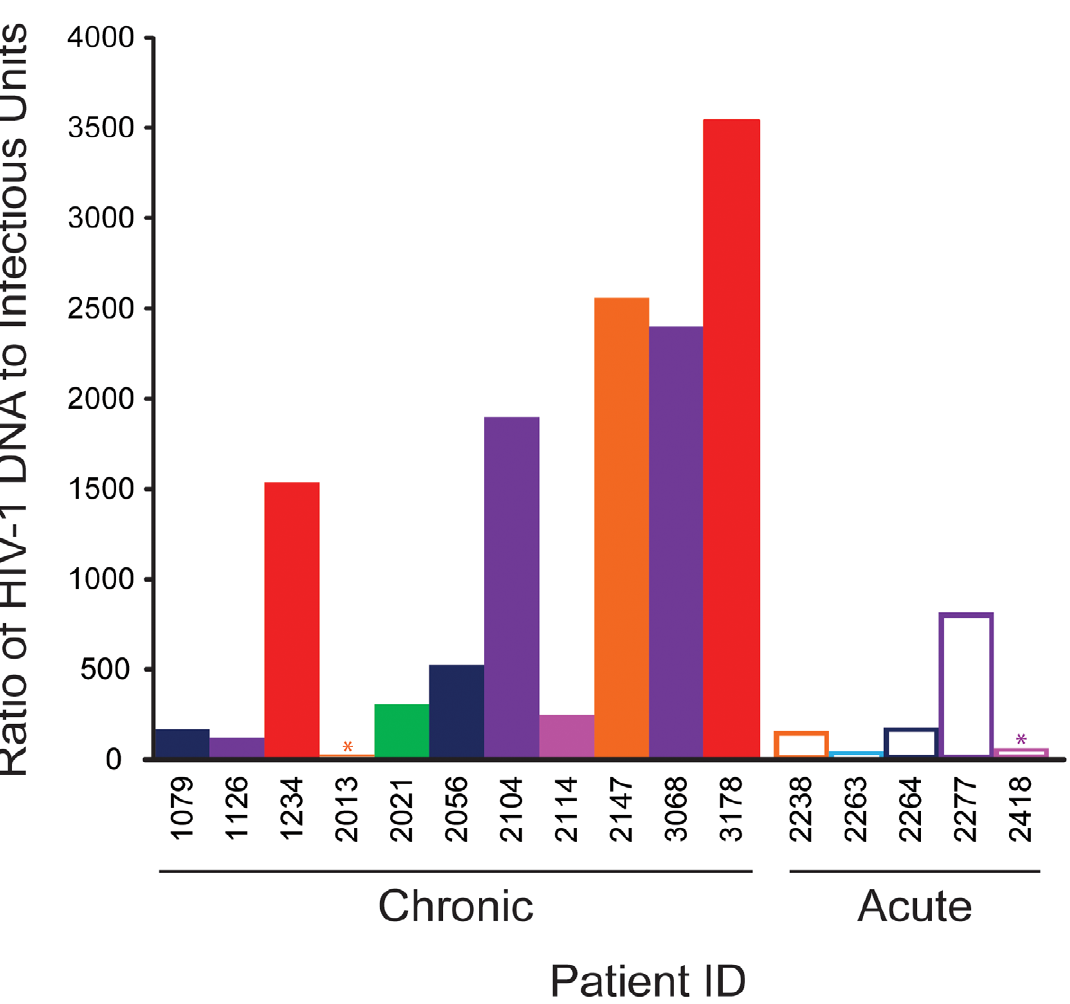
Figure 3. Ratio of infected cell frequencies determined by droplet digital PCR for HIV-1 DNA or by viral outgrowth assay. Analysis was done on the same sample of purified resting CD4 + T cells. * indicates maximum values in cases in which the HIV-1 DNA level was below the limit of detection (2 copies/ml).